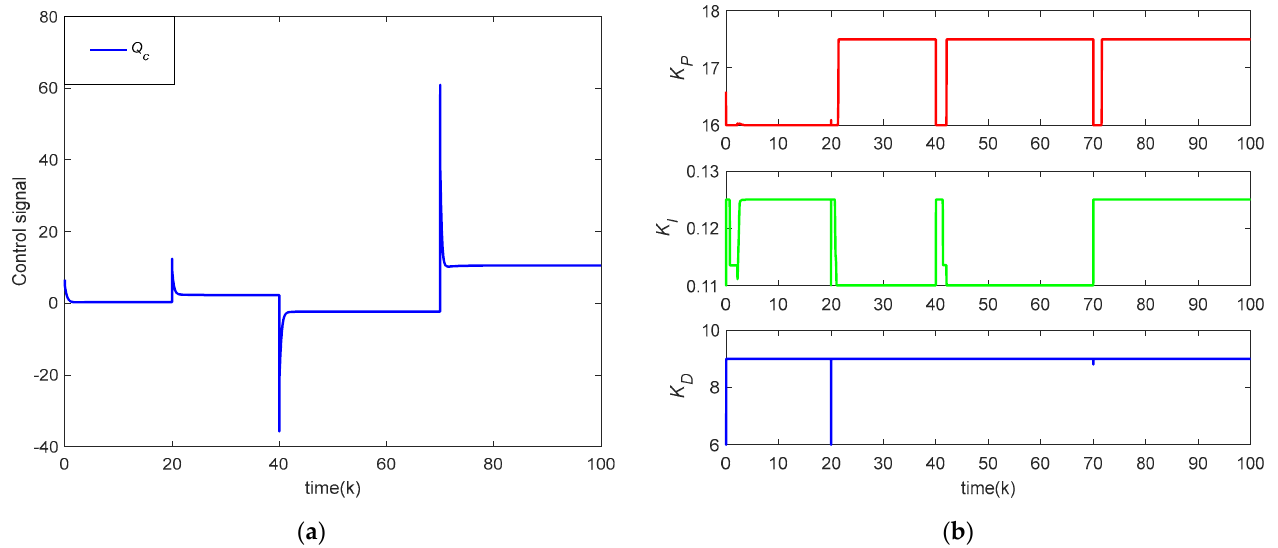
Figure 8. Control signal and controller parameters. ( a ) Changes of the commanded motor torque Q c . ( b ) Changes of K P , K I , and K D .